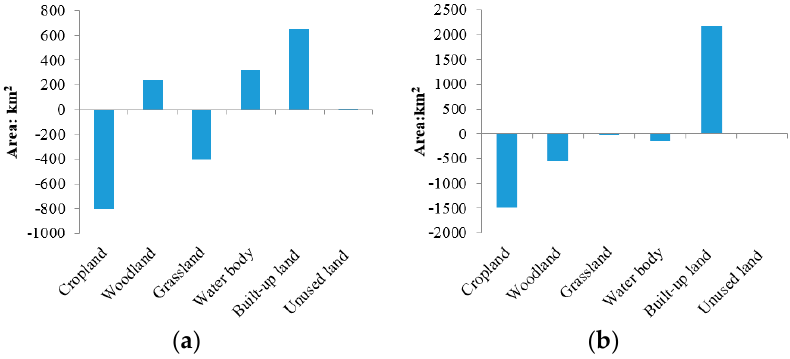
Figure 3. Net change in land-use and land-cover from 1990 to 2017. ( a ) 1990–2000. ( b ) 2000–2017.